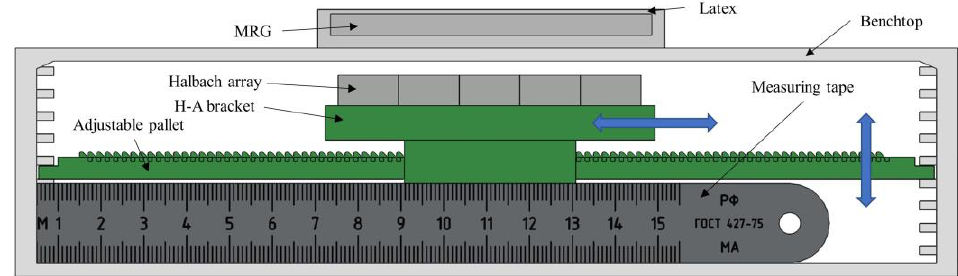
Figure 11. Experimental